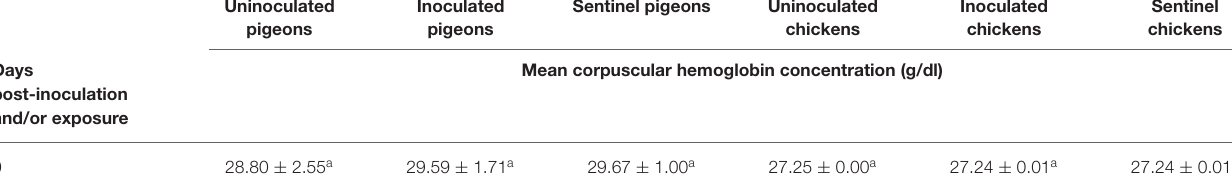
Inoculated Sentinel chickens chickens